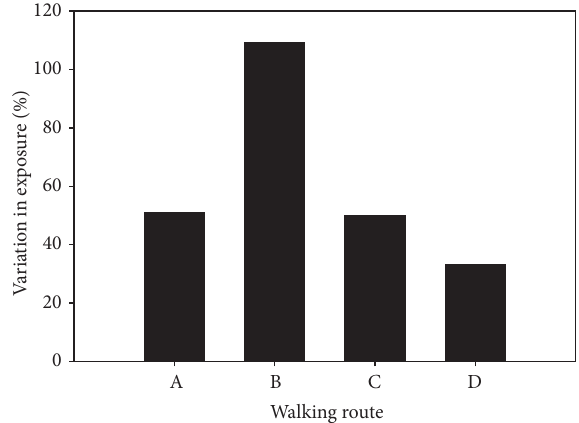
Figure 7: Comparison of the effect of trees on the personal exposure in each walking route. The variation in exposure was calculated as − EXP )/ EXP ] × 100 , where EXP follows: [( EXP notrees notrees trees trees is the average exposure calculated without the effect of trees and EXP trees is the average exposure with the presence of